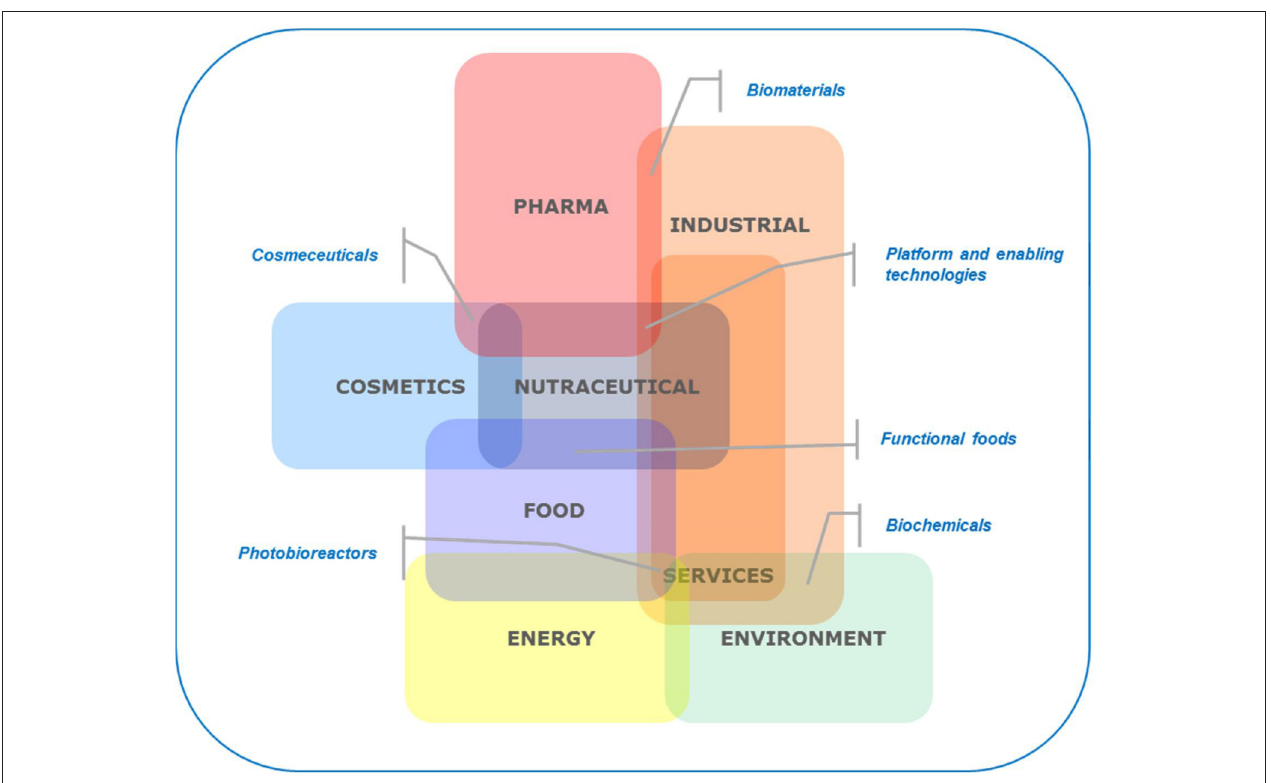
FIGURE 5 | The intersections between the markets